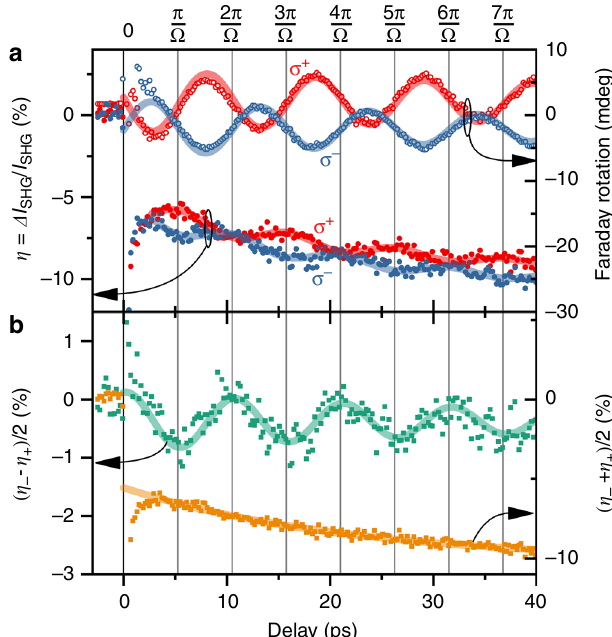
Fig. 2 Experimental observation of coherent spin dynamics by Faraday rotation and SHG. Typical measurement of optically induced spin dynamics by σ + -polarised (red) and σ − -polarised (blue) pump pulses. a Open circles represent Faraday rotation. Closed circles show the relative change of SHG intensity. Solid lines are damped sine (Faraday) and cosine (SHG) fi ts. b Difference (green) and average (orange) of TR SHG changes corroborating helicity-dependent and helicity-independent contributions, respectively. Solid lines represent fi ts according to a damped cosine (green) and a single exponential decay (orange)